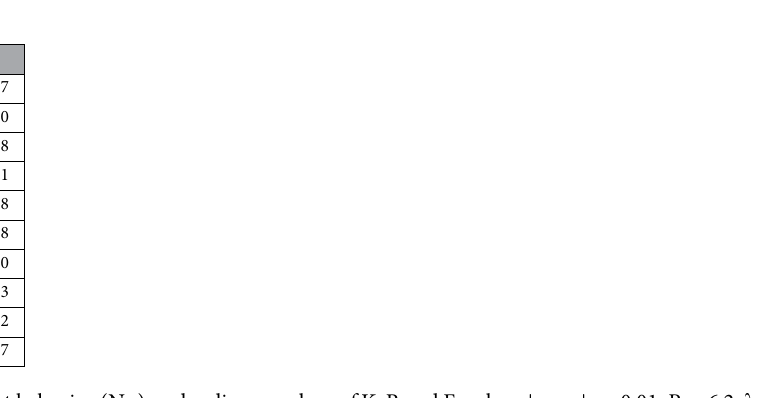
Table 5. Heat transport behavior ( Nu ) under diverse values of K, R and Ec when φ 2 = φ 1 = 0.01, Pr = 6.2, (cid:31) =1, and M =